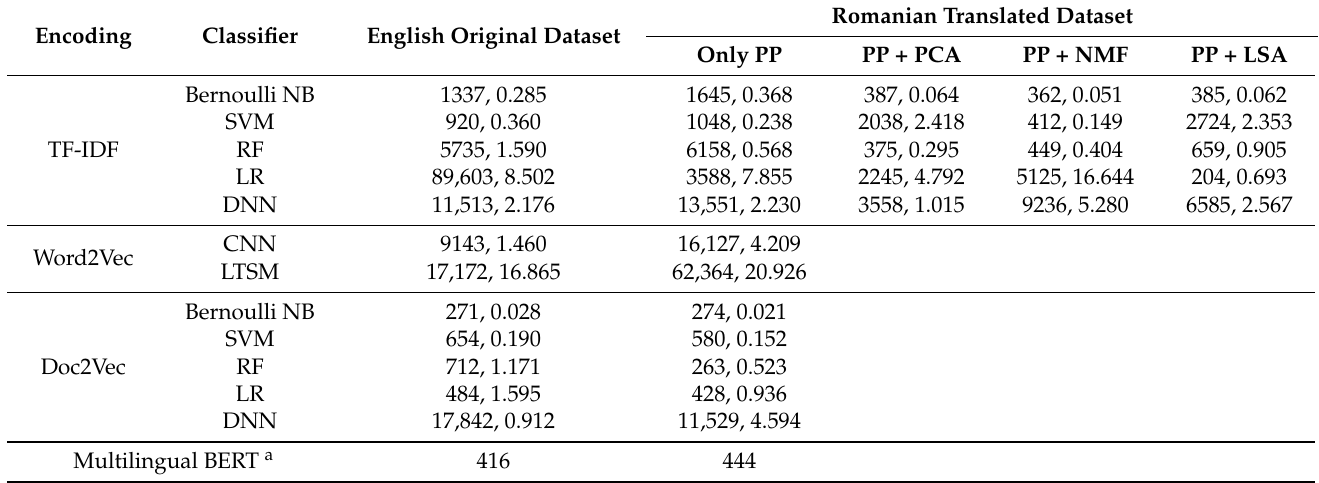
Table 2. Hyperparameter optimization and final model learning time